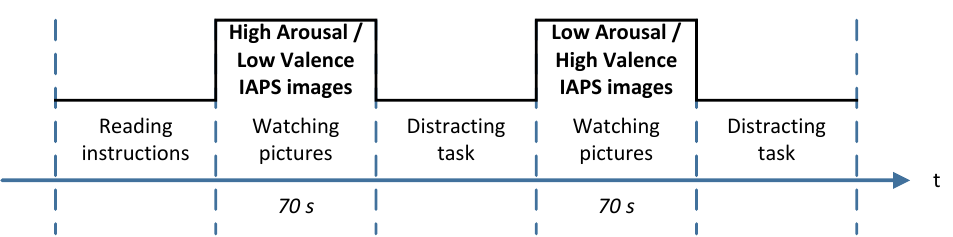
Figure 2. Experimentation time-line. IAPS: International Affective Picture